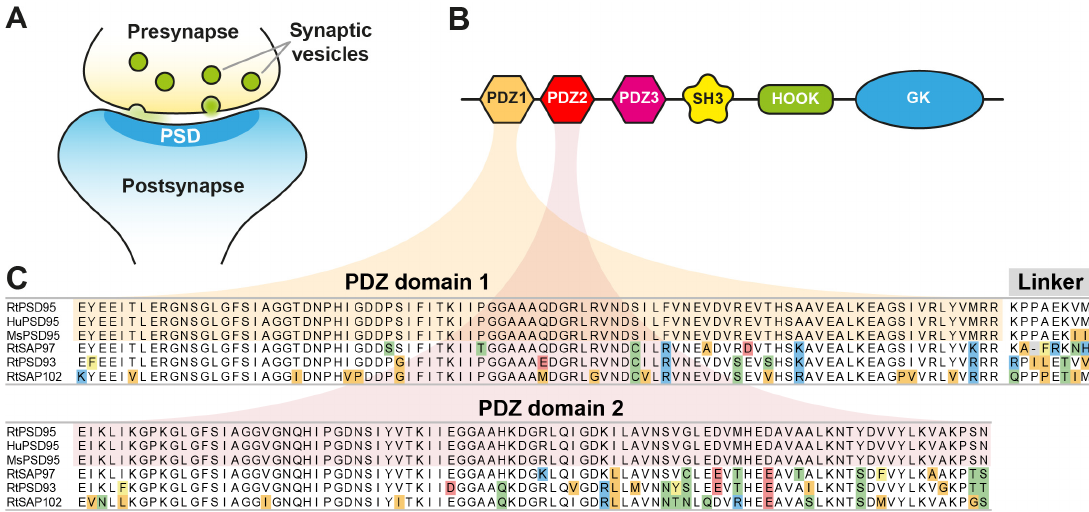
Figure 1. Localization, domain structure and sequence of PSD95. ( A ) A sketch of an excitatory synapse. PSD95 is a major scaffold constituent of the post-synaptic density (PSD), localized juxtaposed to the synaptic vesicle release site. ( B ) Putative domain structure of PSD95: PDZ1/2/3, SH3, HOOK, and the non-catalytic Guanylate Kinase domain (GK). ( C ) Sequences of PDZ domains 1 and 2 of rat (Rt), human (Hu), and mouse (Ms) PSD95, as well as the most closely related proteins PSD93, SAP97, and SAP102 from rat. Within this sequence stretch, the rat and human PSD95 sequences are identical and differ by only two amino acids in the linker connecting PDZ1 and PDZ2 from the respective mouse sequence.